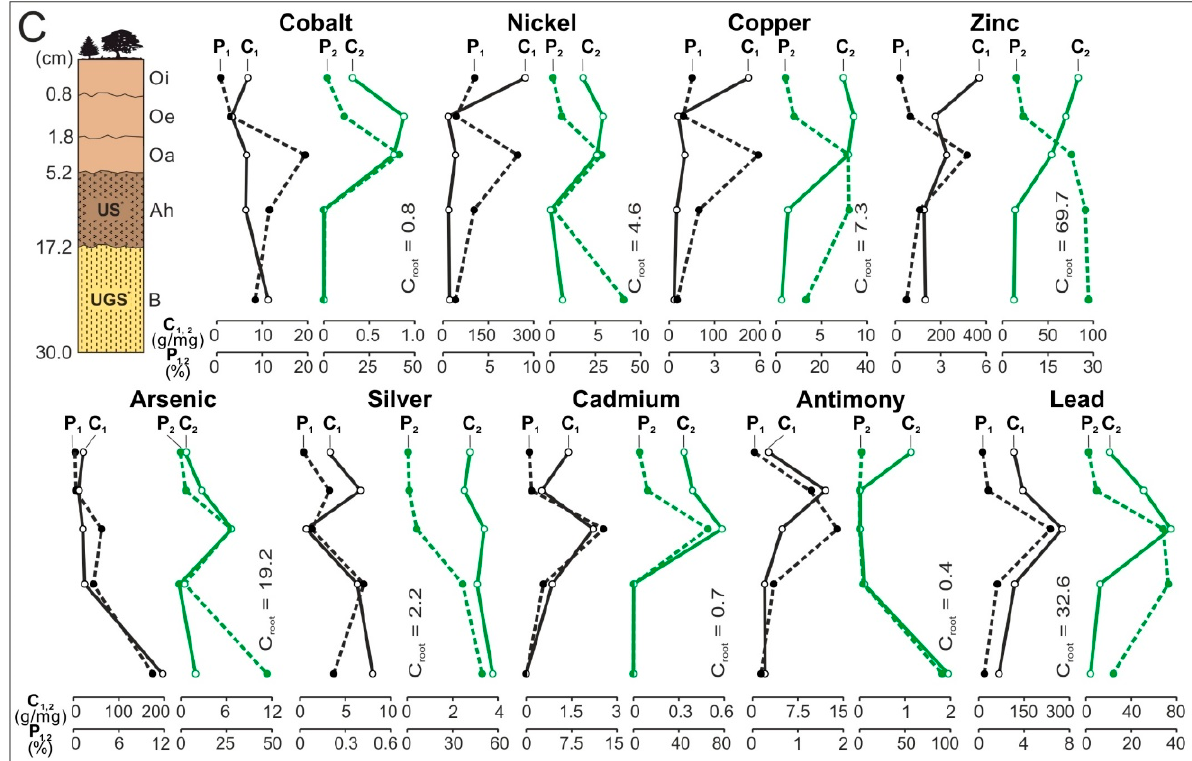
Figure 3. The content of elements in magnetic (C 1 ) and nonmagnetic fractions (C 2 ) and their proportions in determining the average element concentration in the whole subhorizon/horizon of the topsoil (respectively, P 1 and P 2 ), and also the element content in tree roots and undergrowth (C root ) in topsoil in the tested areas ( A – C ). * Soil granulometric groups: LUS—loamy and unsorted sand, FUS—fine and unsorted sand, US—unsorted sand, UGS—unsorted and gravelly sand.